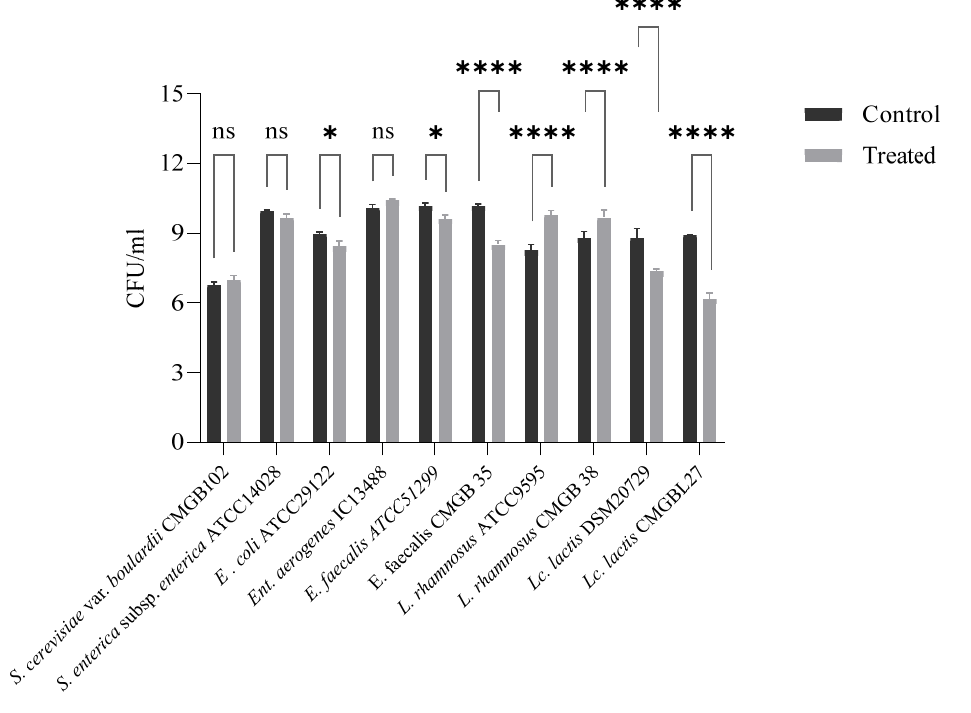
Figure 2. Bacterial cell viability in the presence of NN product; p value *, **** < 0.05; ns = p value > 0.05 (non-significant